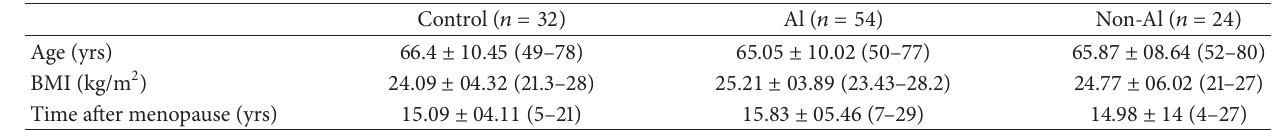
Figure 1: Structures of pyridinoline (PYD) and deoxypyridinoline (DPD). Upper: pyridinoline (molecular weight: 429); lower, deoxypyridi- noline (molecular weight: 413). Table 1: Age, BMI, and time after menopause of the study